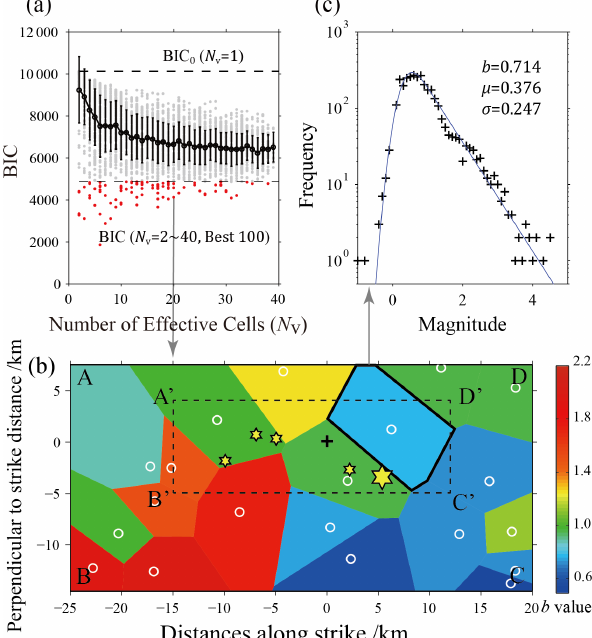
Figure 3. An example of calculating the parameters of the OK1993 model in terms of the frequency–magnitude distribution based on a data-driven approach. (a) Distribution of BIC values versus the number of effective cells N v in the Voronoi tessellation. The black dots and error bars are commensurate with the mean value and 1 standard deviation of BIC values under the corresponding N v , re- spectively. The top horizontal dashed line marks the BIC values of the entire spatial region without mesh generation (BIC 0 , N v = 1). The red dots show the BIC values with the best-100 solutions se- lected, while the gray dots are the other BIC results according to N v . (b) Example of Voronoi tessellation of N v = 20 and one of the best-100 models selected. The white circles are the positions of the Voronoi nodes, and the resulting partitions are color coded by their estimated b values (obtained from the β value in the OK1993 model). (c) Example of fitting result for the frequency–magnitude distribution (FMD) of the OK1993 model in the Voronoi cell indi- cated by a thick line in graph (b)